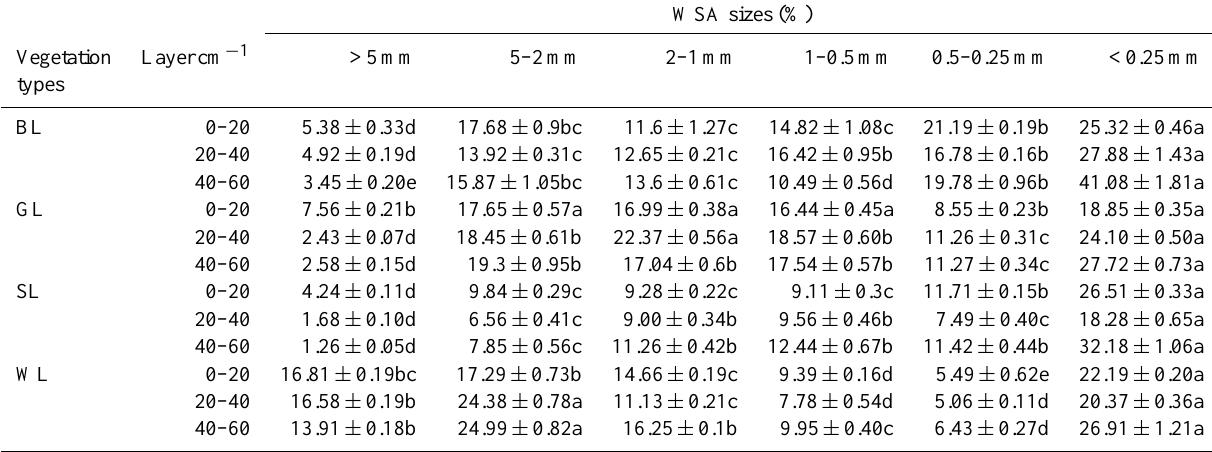
Note: different small letters in the same row indicate significant difference at 0.05 level among different